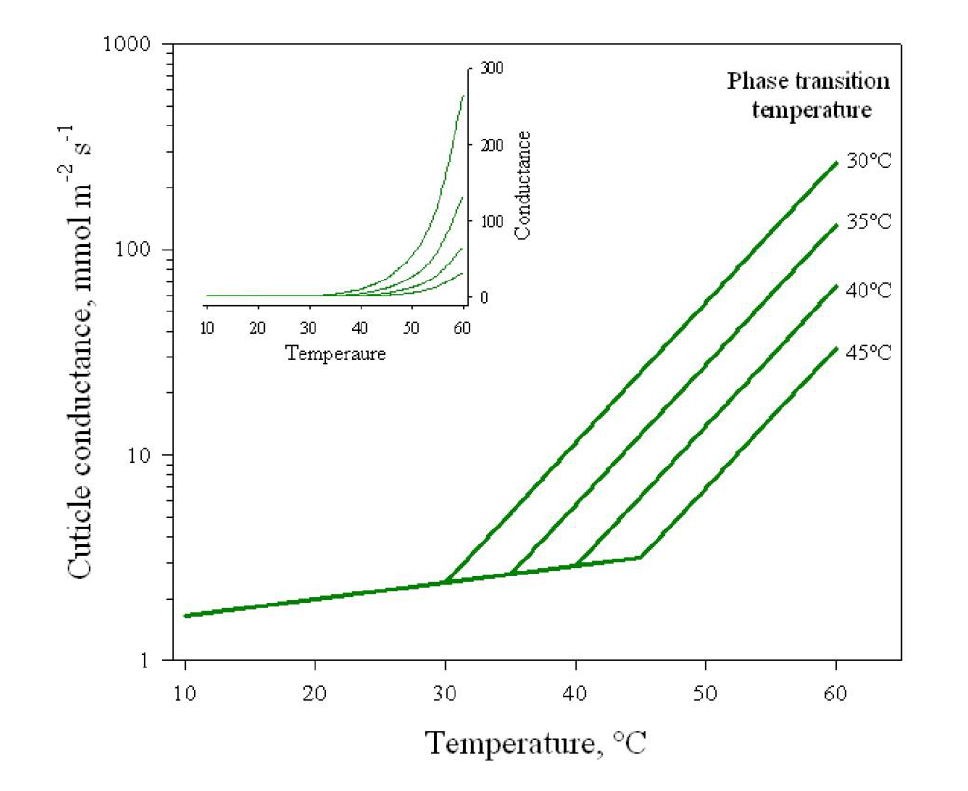
Figure 2. Bi-phasic model for the temperature dependence of leaf cuticular conductance (gmin). The conductance follows two Q10 curves above and below a phase transition temperature Tp. The insert shows the curves on a linear y